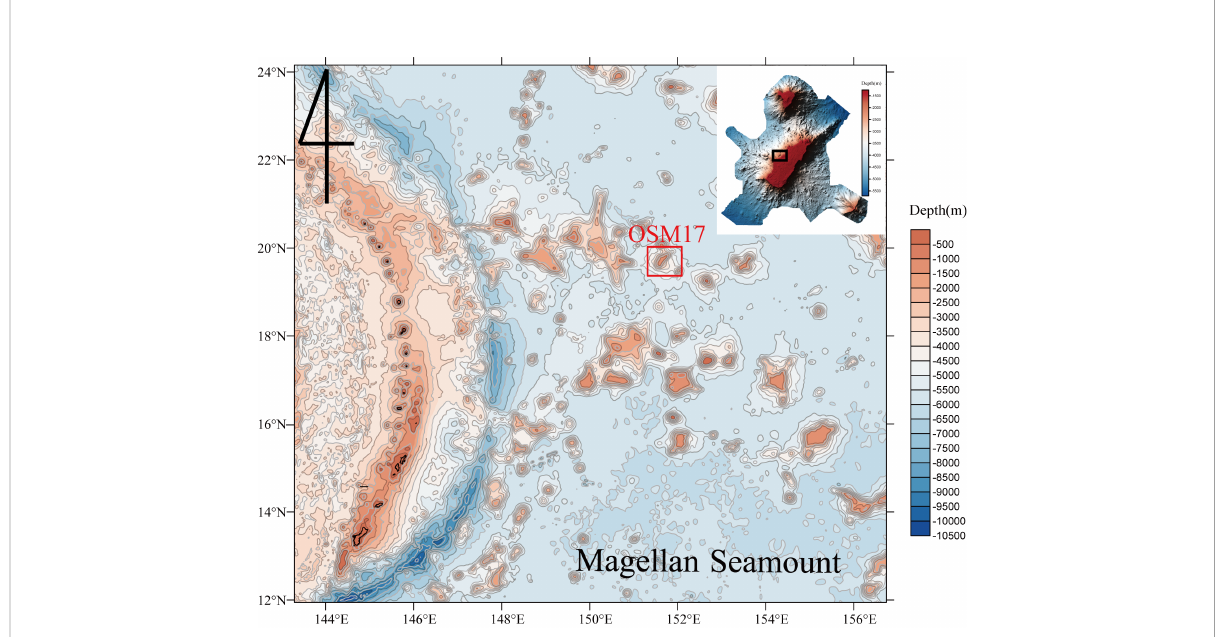
FIGURE 1 Bathymetry map of the western Paci fi c. Upper right of the map is a detailed bathymetry map of the study area, OSM17, using multibeam data. The black square denotes the epibenthic sledge